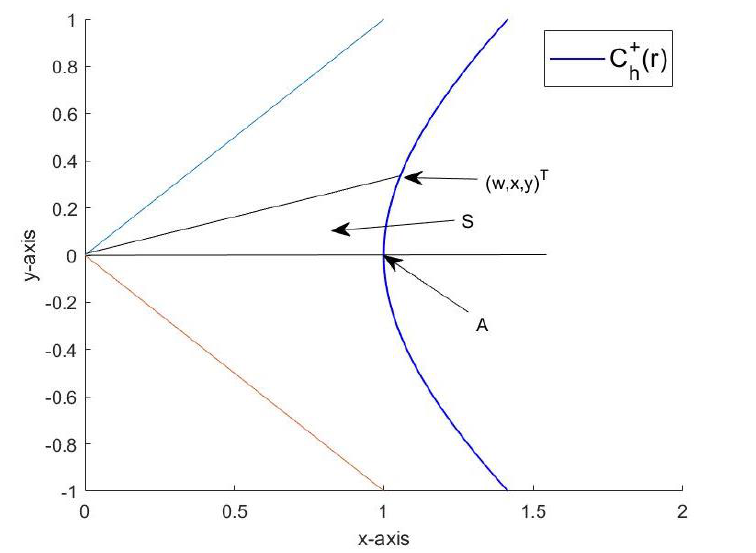
Figure 9. Sector S belongs to the plane which is spanned up by the vectors o , x = ( w , x , y ) T and (cid:112) A = w 2 − x 2 − y 2 • e